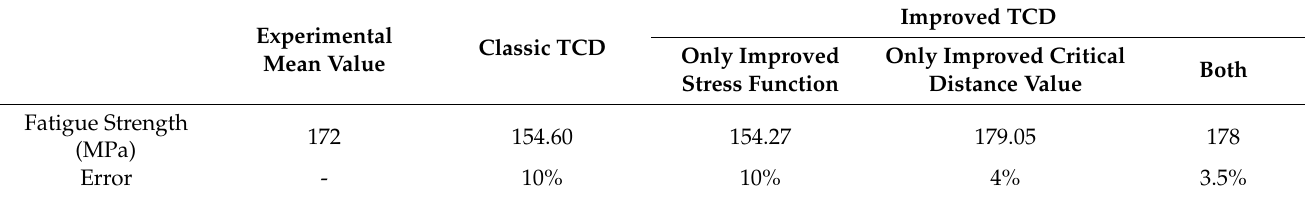
Table 8. Comparison of